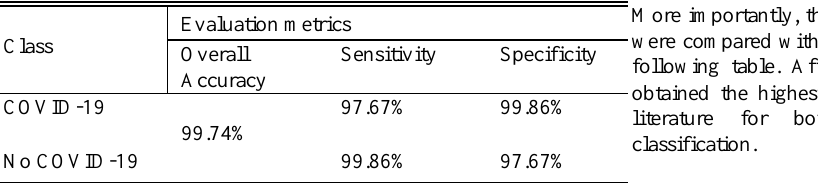
Table 3. The performance results of the binary classification (COVID-19 vs. No COVID-19).